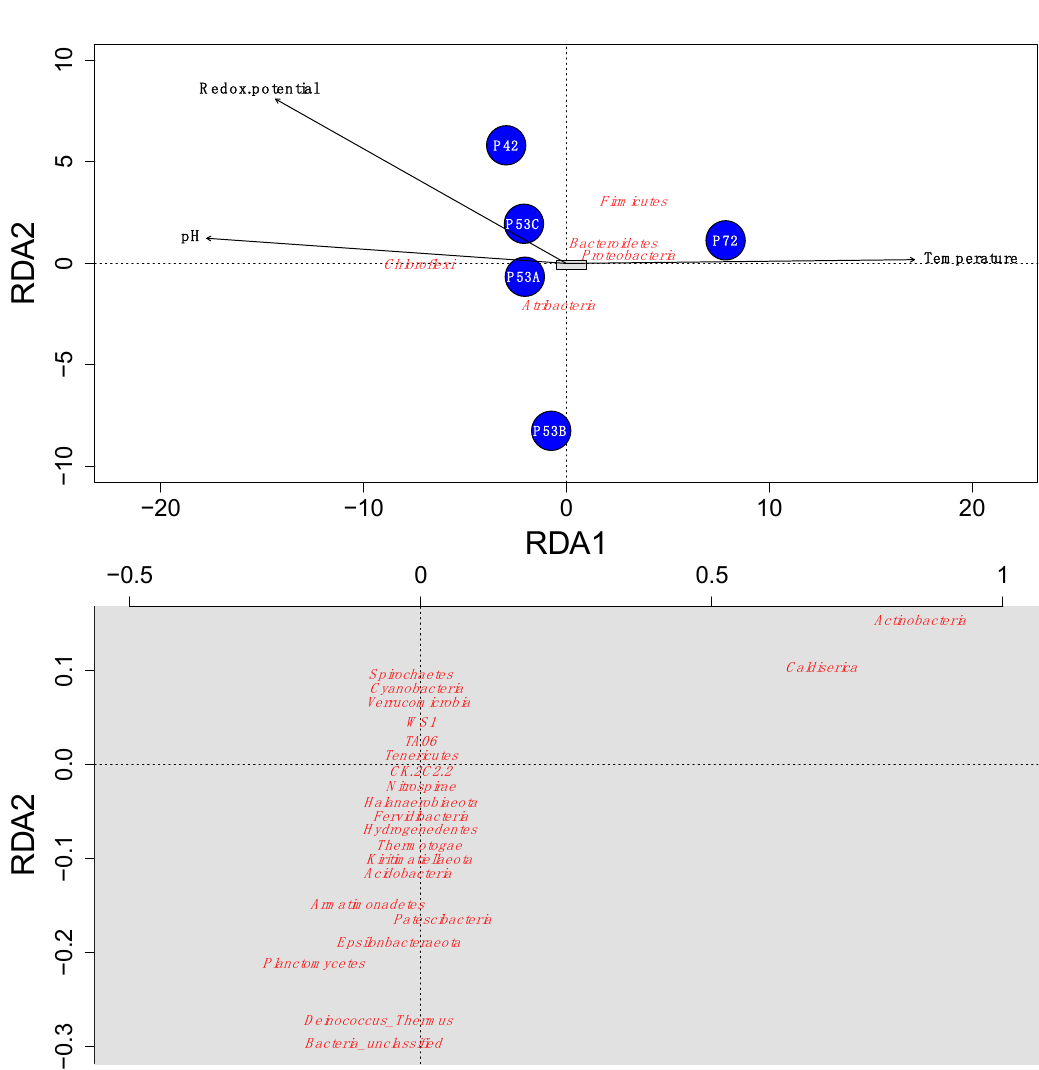
Figure 4. Redundancy analysis (RDA) ordination plot that illustrates the relations between the Lirima hot springs’ microbial community composition (red) and the environmental variables that explain most of the variance (black) in each of the springs (blue circles). The grey rectangle in the first plot (above) is represented in the second plot (below) with the ordination of the species with less abundance. The ordination of the species in the second plot was rearranged when plotted to accomplish a better resolution.